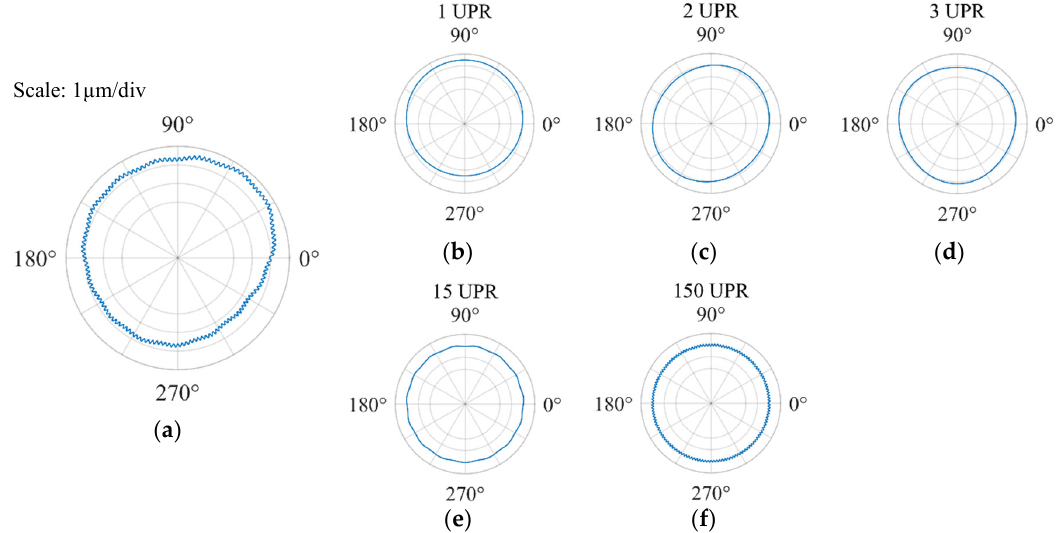
Figure 3. A schematic diagram of the contours with the harmonics containing different frequency components: ( a ) overall circular contour; ( b ) harmonic error with 1 UPR; ( c ) harmonic error with 2 UPR; ( d ) harmonic error with 3 UPR; ( e ) harmonic error with 15 UPR; ( f ) harmonic error with 150 UPR.